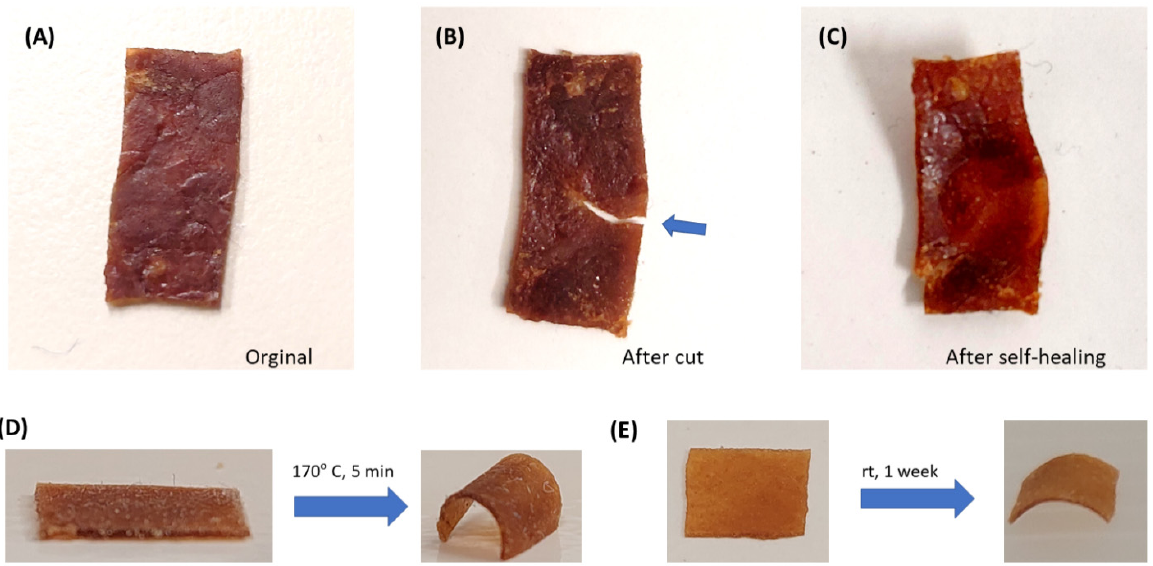
Figure 9. Photographs of Vitrimer 3 before cutting ( A ), after a cut in the middle ( B ) and self-healed after pressed for 5 min under 20 N at 180 °C ( C ). Shape fixing of Vitrimer 3 by applying a pressure at 170 °C ( D ) and room temperature ( E ).